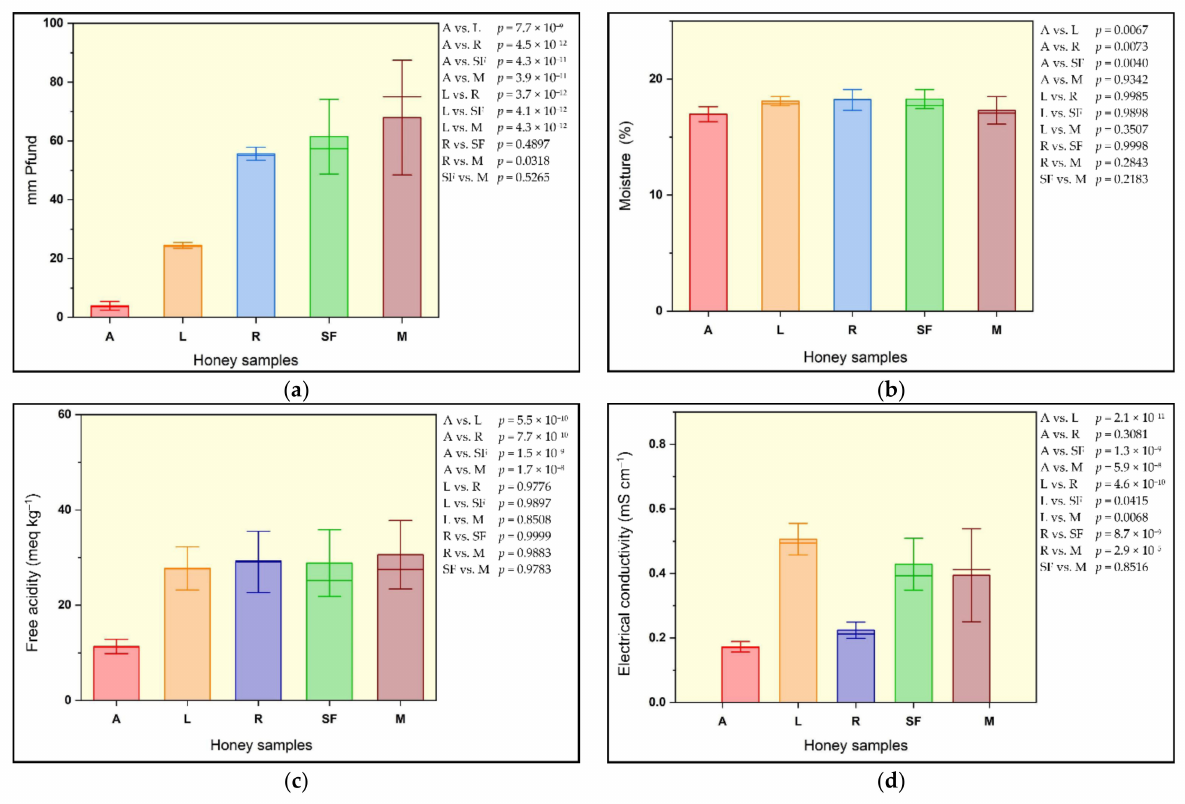
Figure 2. Mean content, standard error and mean line values of selected honey sample parameters: